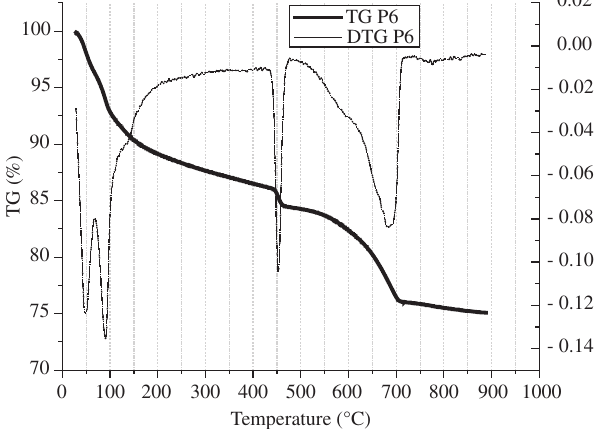
Figure 4. TG curve of the paste